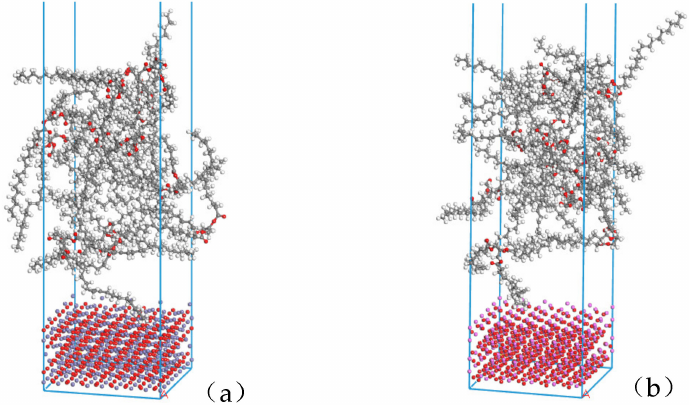
Figure 4. Composite structure models: ( a ) Fe 3 O 4 with the insulating oil layer structure model NG-Fe 3 O 4 , ( b ) Al 2 O 3 with the insulating oil layer structure model NG-Al 2 O 3